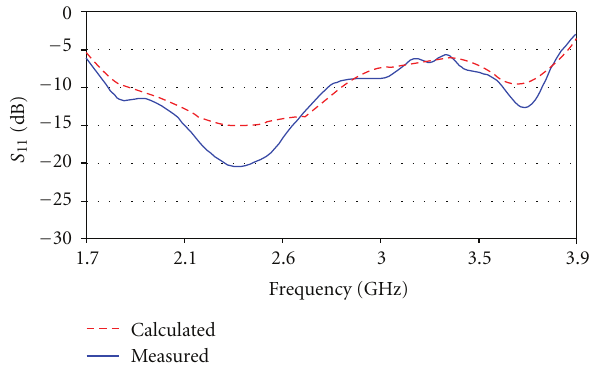
Figure 6: Calculated and measured return loss of the high-band antenna of the second dual configuration.